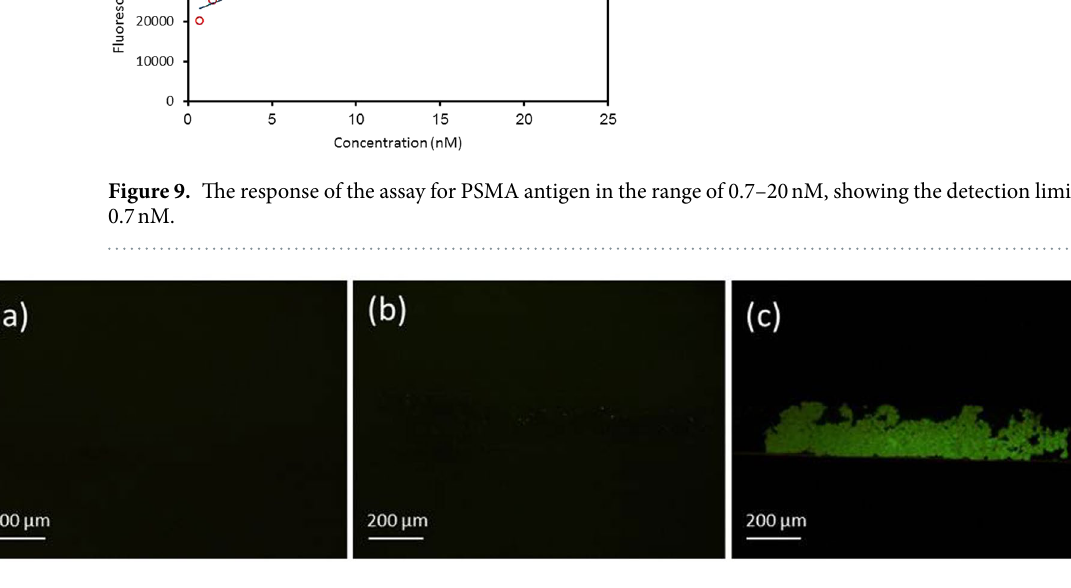
Figure 10. Fluorescence images of the concentrated immunocomplexes on the sensing zone of 1–3 set-up for serum samples of ( a ) 0 nM, ( b ) 1 nM, and ( c ) 20 nM PSMA concentrations verifying the selectivity towards